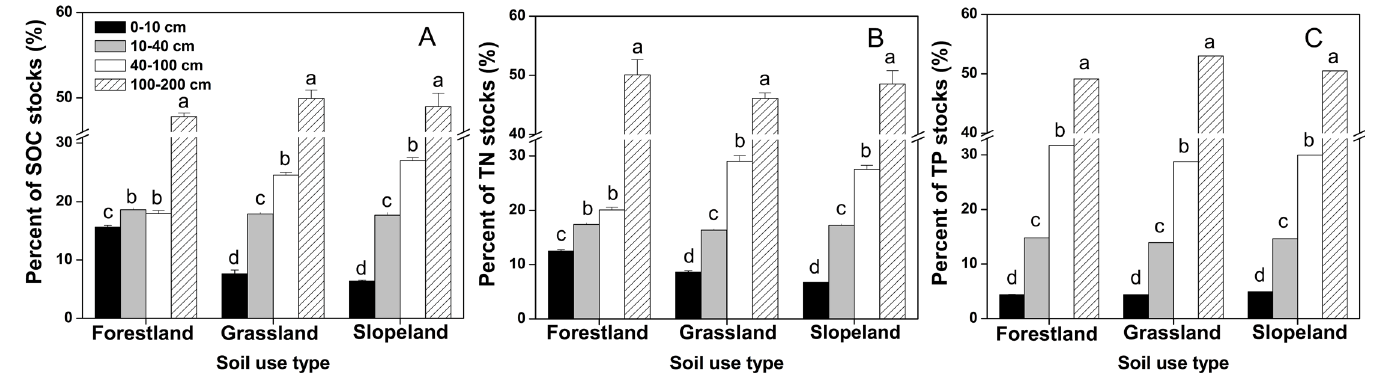
Fig 3. Distribution ratios of the SOC (A), TN (B) and TP (C) stocks in soil at a depth of 0 – 200 cm. The error bars are the standard errors. Different lowercase letters indicate significant differences at 0.05 (P < 0.05) levels among different soil depths within the same land use type.